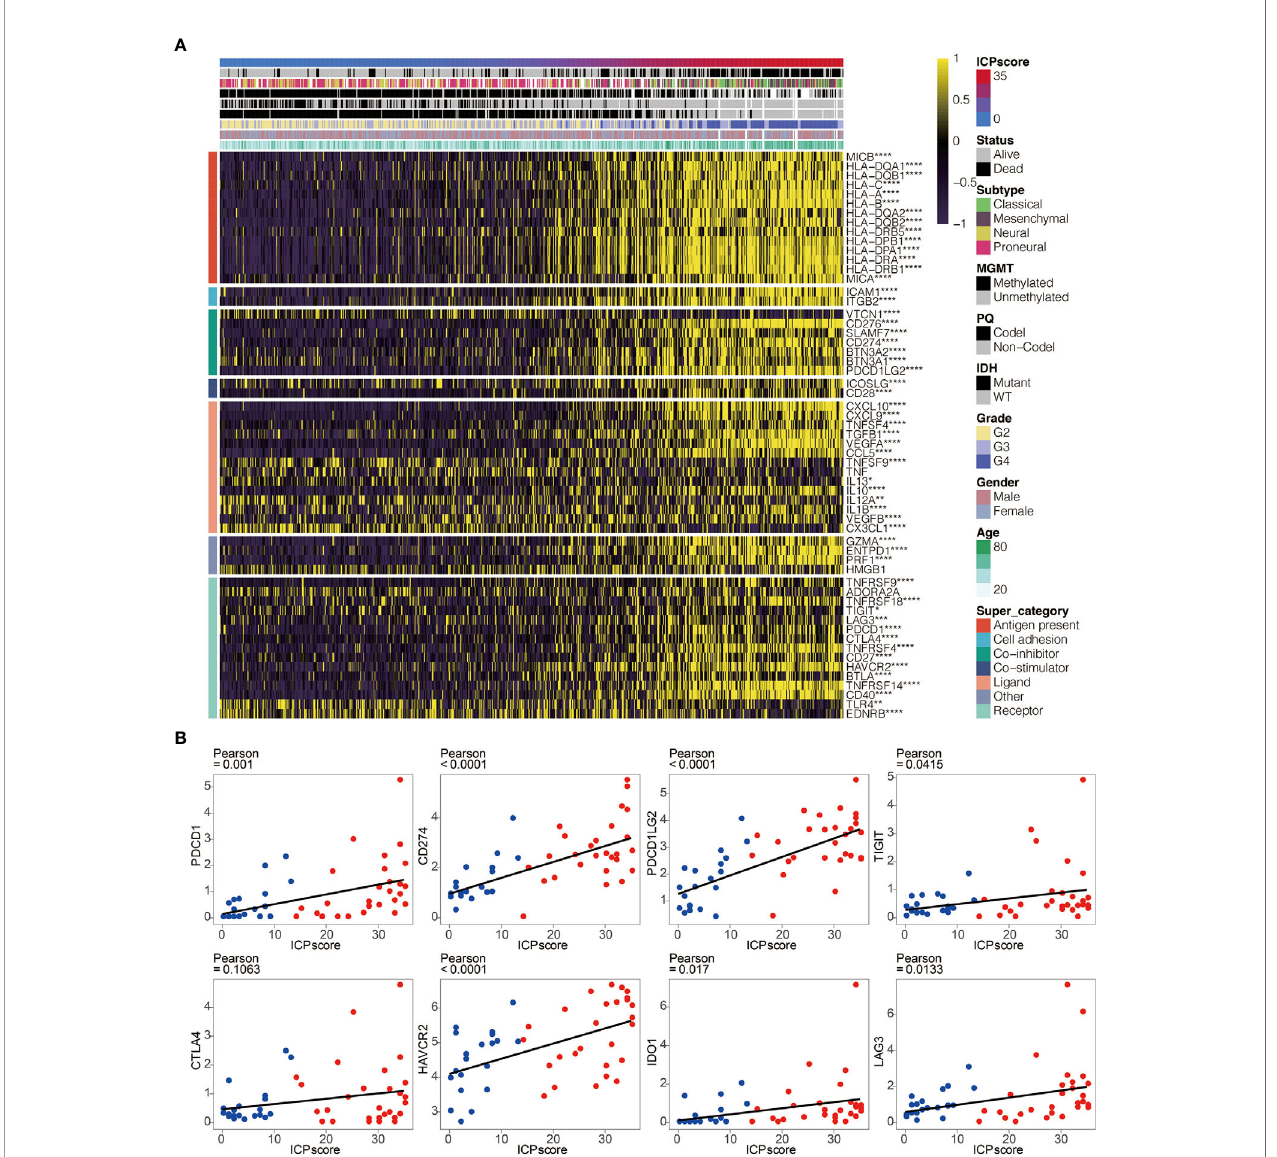
FIGURE 6 | ICP score correlated with immune checkpoints. (A) Heatmap illustrating the expression pattern of immune checkpoints in ICP score. (B) Scatter plots depicting a positive correlation between ICP score and eight classical immune checkpoints, including PDCD1, CD274, PDCD1LG2, TIGIT, CTLA4, HAVCR2, IDO1, and LAG3. *P < 0.05; **P < 0.01; ***P < 0.001; ****P <